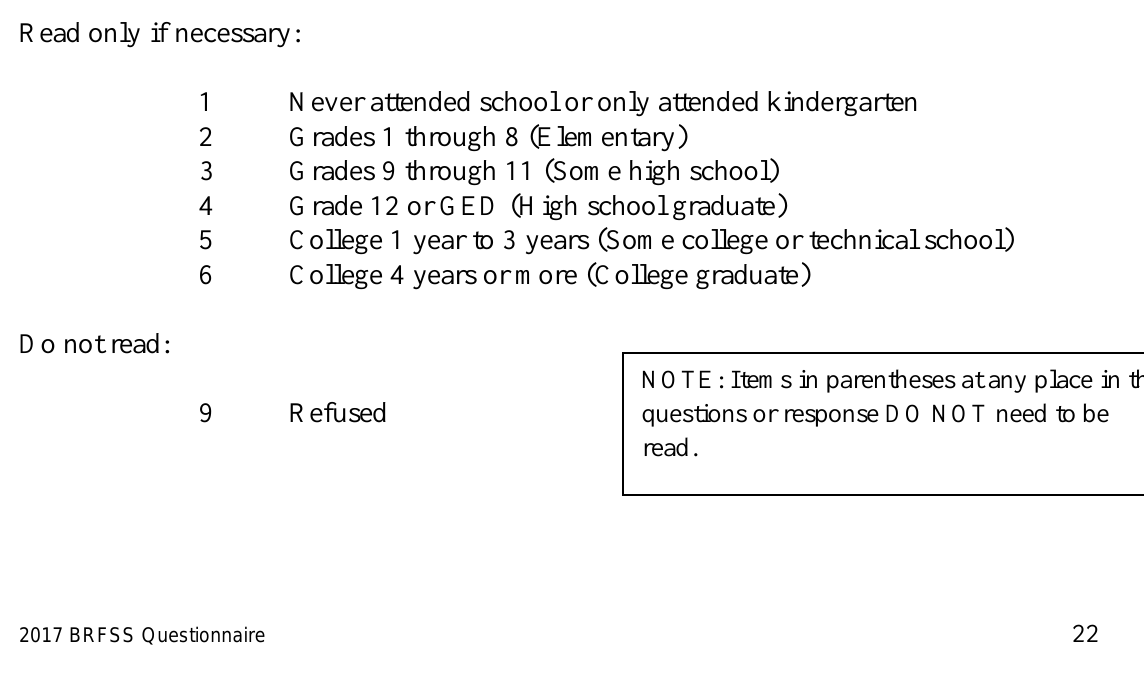
NOTE: Items in parentheses at any place in the questions or response DO NOT need to be